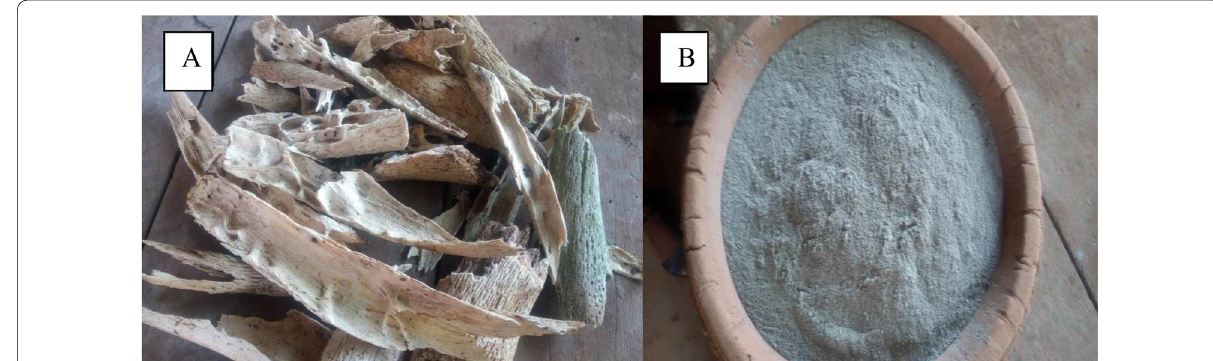
Fig. 2 A Photograph of cow horn bony core, B the sieved cow horn (bone) (Ezeh et al. 2020)